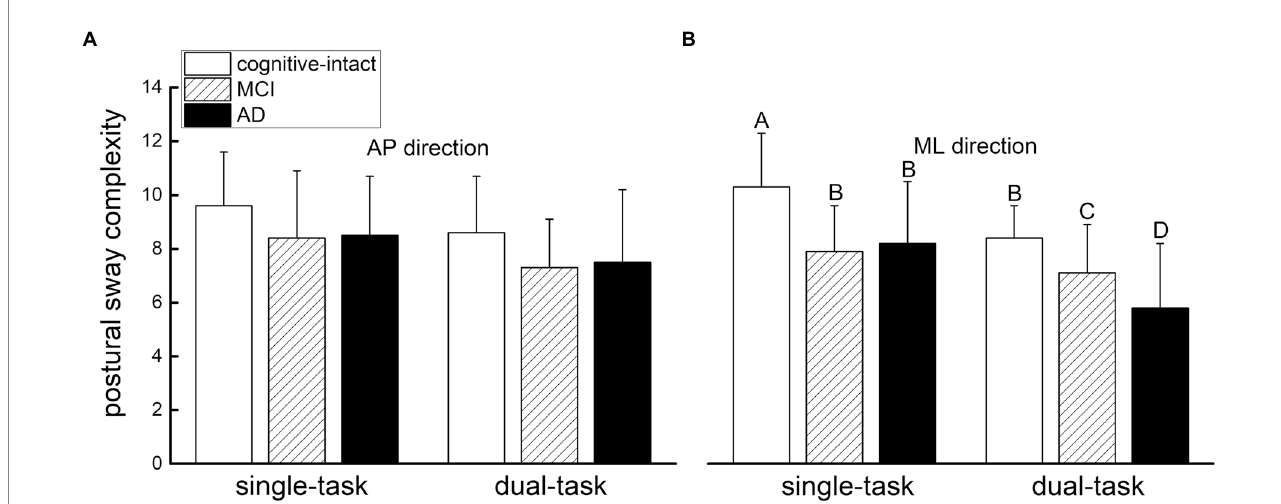
FIGURE 1 Postural sway complexity in the anterior–posterior (AP) (A) and medial-lateral (ML) (B) directions within each group under single-task (i.e., quiet standing) and visual-search dual-task condition. Repeated-measures ANOVA models revealed significant main effects of group ( F > 4.8, p < 0.01) and condition ( F = 7.7, p < 0.007) on both AP and ML sway complexity. A significant interaction was observed between group and condition for ML sway complexity ( F = 3.7, p = 0.03), but not for AP sway complexity ( F = 0.22, p = 0.88). Compared to single-task sway complexity within cognitively-intact group, greater reduction in complexity was observed with increased severity of cognitive impairment (i.e., MCI and AD) and during performance of the visual-search dual-task. Different letters in the figure indicate significant differences of factor means based upon post-hoc